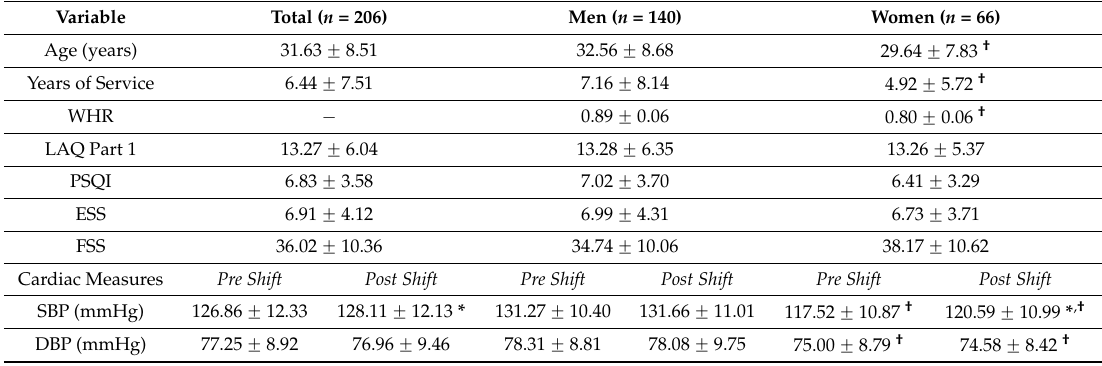
Table 1. Shift work police officers’ ( n = 206) demographics, questionnaires scores and cardiac measures.